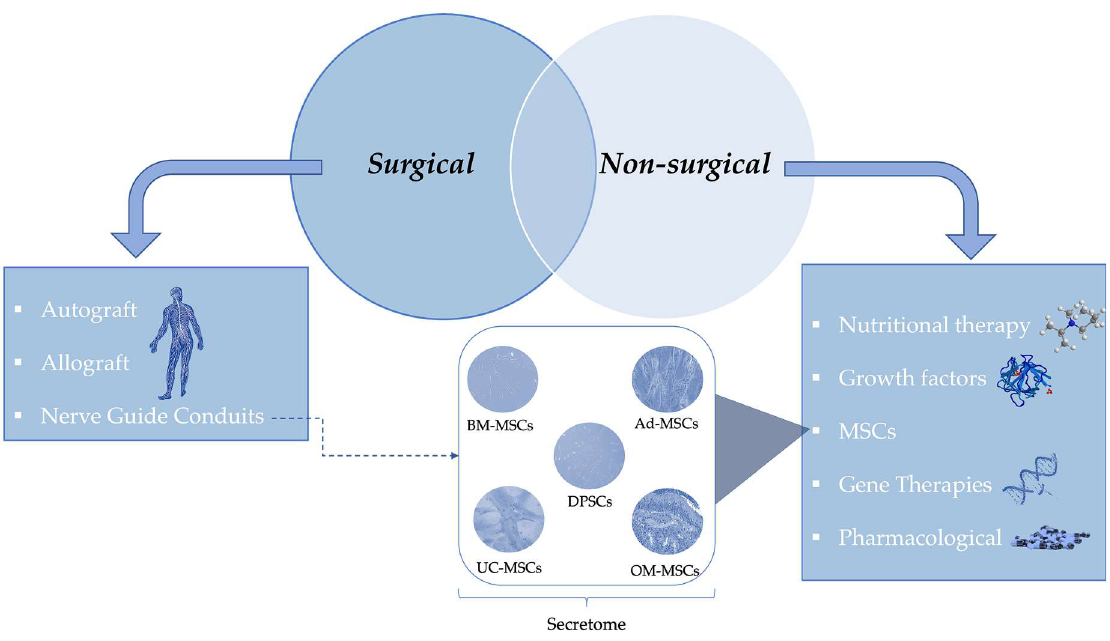
Figure 3. Schematic representation of the surgical and non-surgical treatments for PNI. The dotted arrow refers to the combination of nerve guide conduits with MSCs or their secretome, used